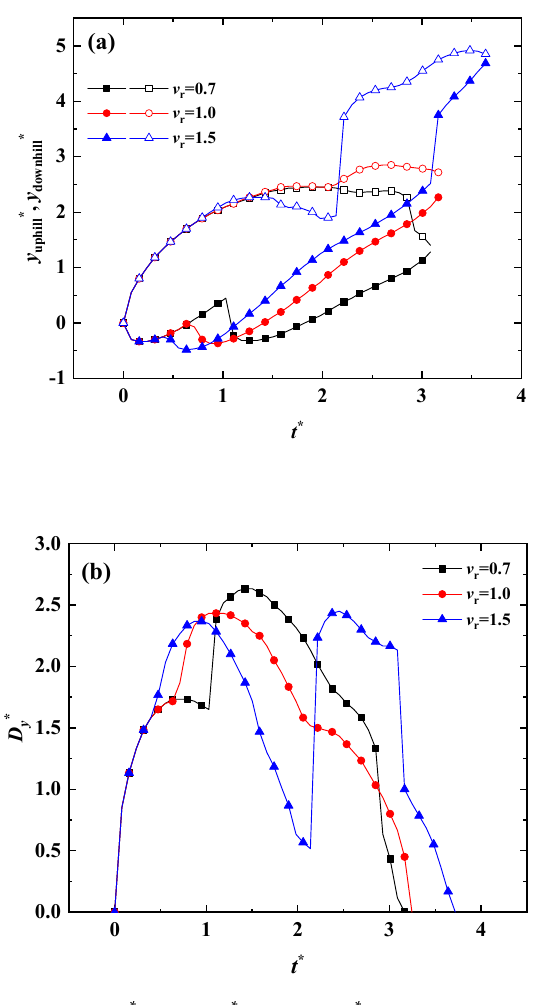
Figure 8. The evolutions of ( a ) y uphill * , y downhill * , and ( b ) D y * with various velocity ratios at L z * = 1.18.